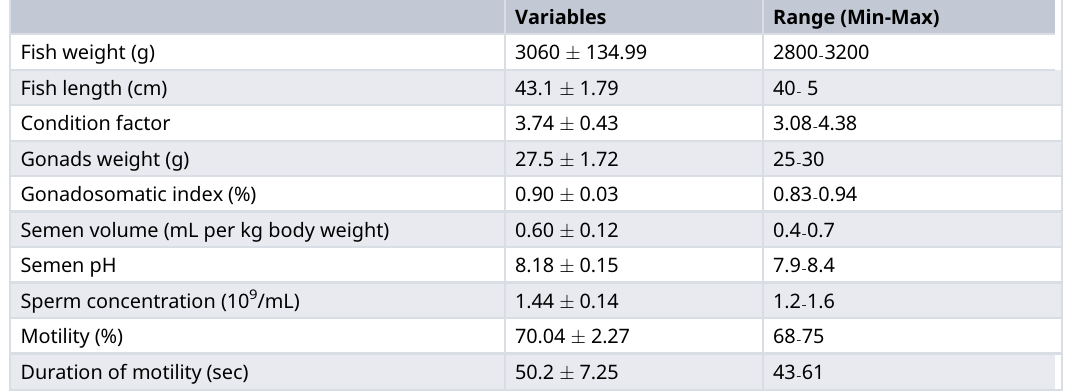
Table 2. Reproduction characterization in sago strain of giant gourami males broodfish (Mean (cid:3)